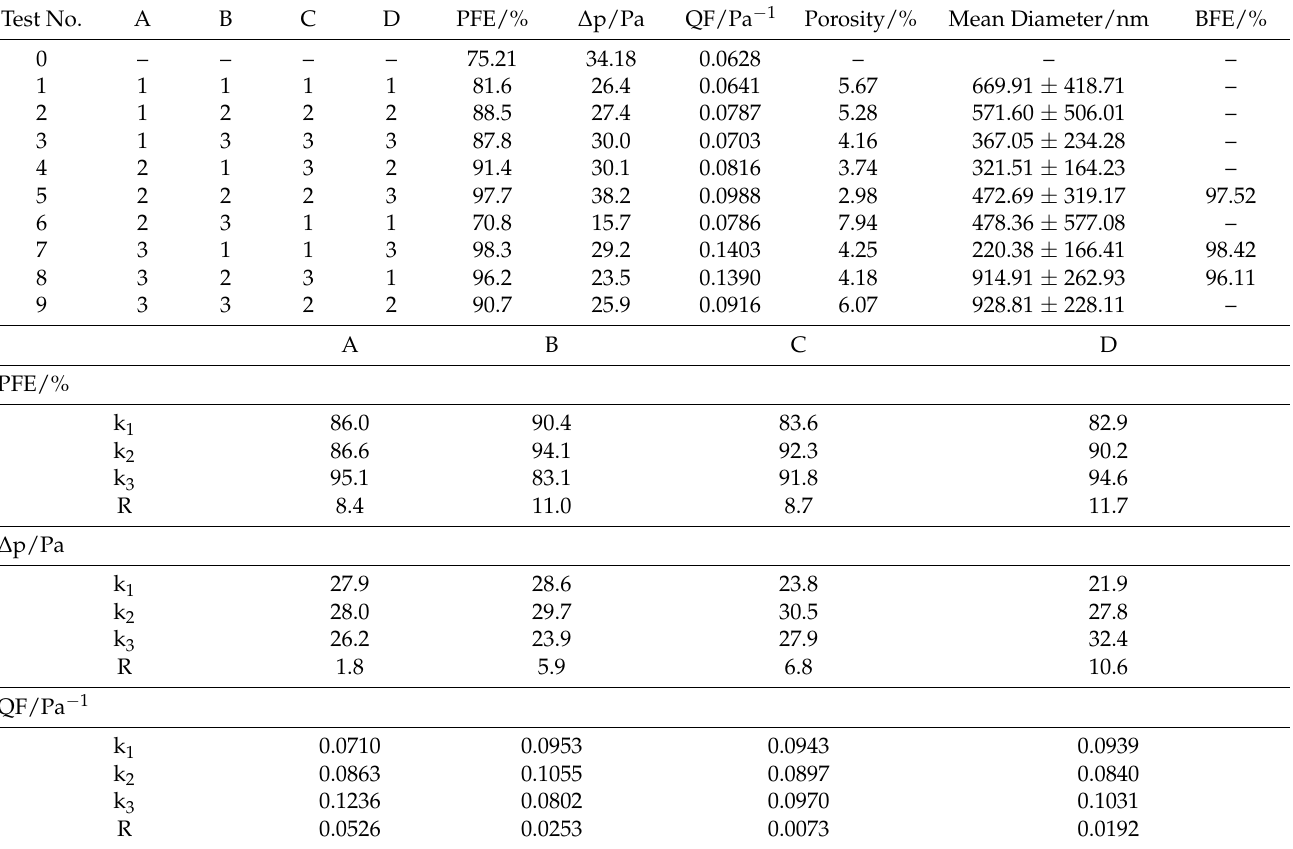
Table 3. Results of L 9 (4 3 ) orthogonal experiments, filtration efficiency, respiratory resistance, porosity, mean diameter, and bacterial